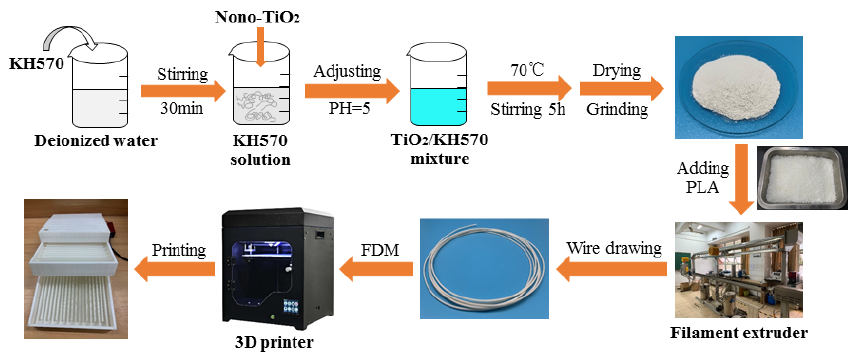
Figure 2. Modified TiO 2 preparation process, material production, and finished product printing